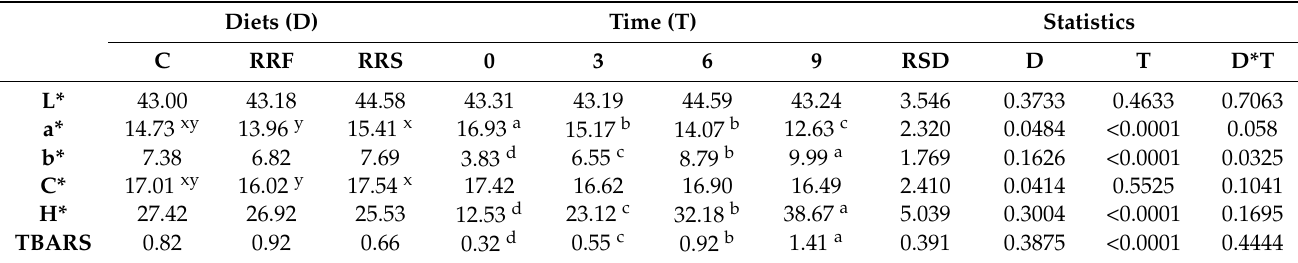
Table 3. Effect of the inclusion of residues of rosemary and time of storage on color and lipid oxidation (mg MDA/kg meat)